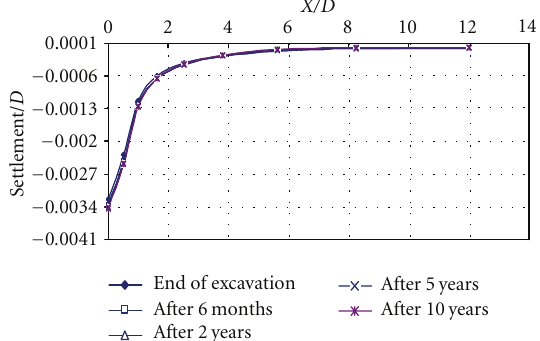
Figure 19: Subsurface settlement along section C-C at di ff erent consolidation times using MCC soil model.